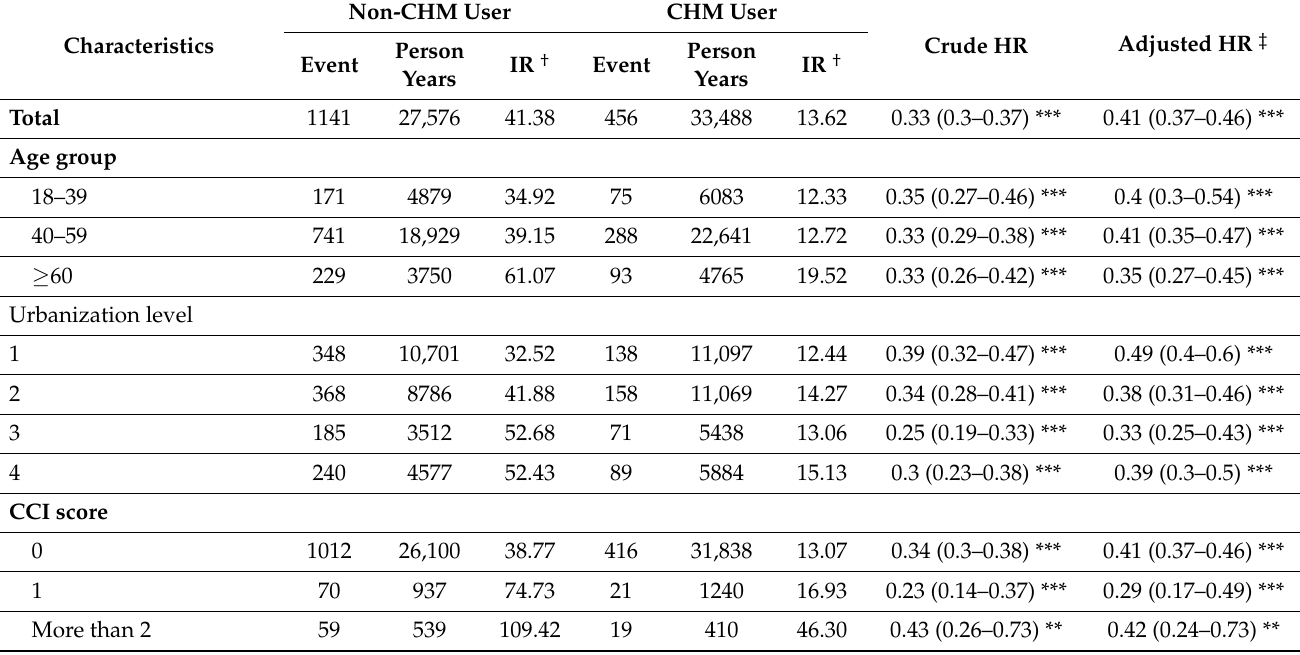
Figure 1. Mortality number in breast cancer patients with and without taking CHM. Table 2. Breast cancer mortality rate among CHM user and non-CHM user stratified by age group, urbanization level, CCI score, treatment, and drugs.